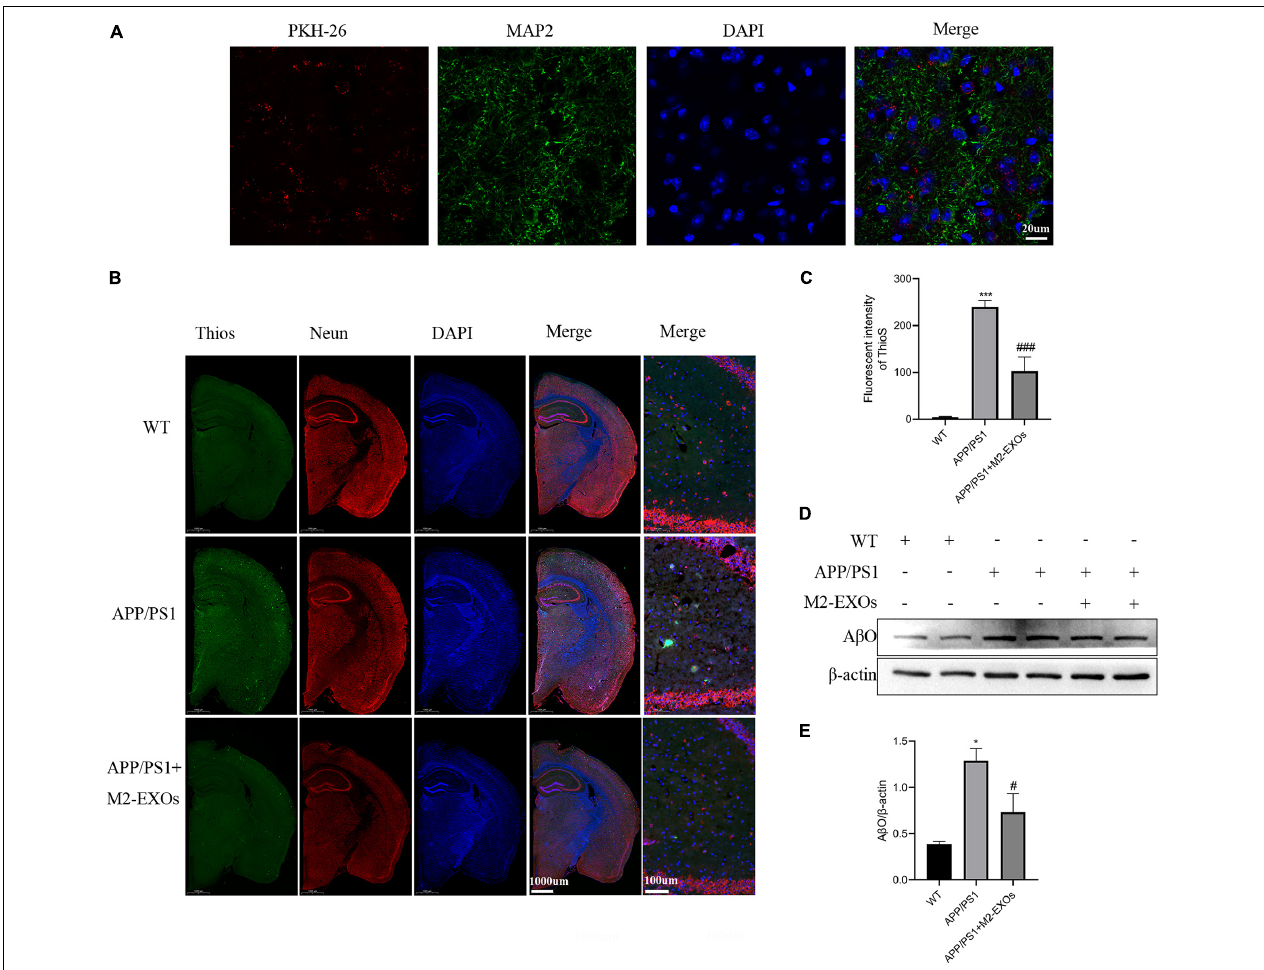
FIGURE 7 | Effect of exosomes on amyloid levels and A β -oligomer expression in APP/PS1 mice. (A) Images of PKH-26-labeled exosomes (red) and neurons (green) after three days of exosome injection through the tail vein were observed by confocal microscopy. (B) Representative images of brains section stained with thioflavin S (ThioS), NeuN, and DAPI. (C) Quantitative analysis of Thios fluorescence intensity. (D) Immunoblot images of A β oligomer in all groups of mice. (E) Quantitative analysis of A β oligomer. ** P < 0.01 vs. WT, *** P < 0.001 vs.WT, # P < 0.05 vs. APP/PS1, ### P < 0.001 vs.